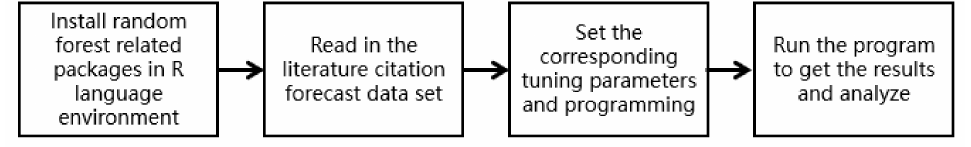
Figure 2. R language modeling